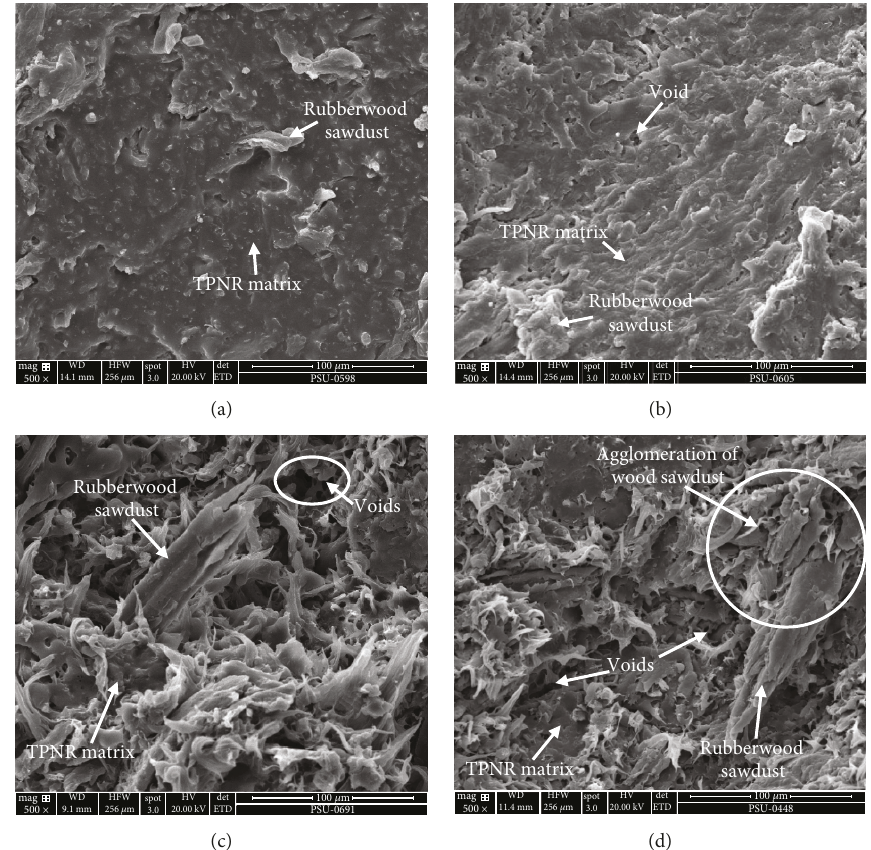
Figure 5: SEM images of R60/P40 composites with (a) 30 wt% RWS and (b) 60 wt% RWS and R30/P70 composites with (c) 30wt% RWS and (d) 60 wt% RWS. All formulations reinforced with RWS 80 mesh.